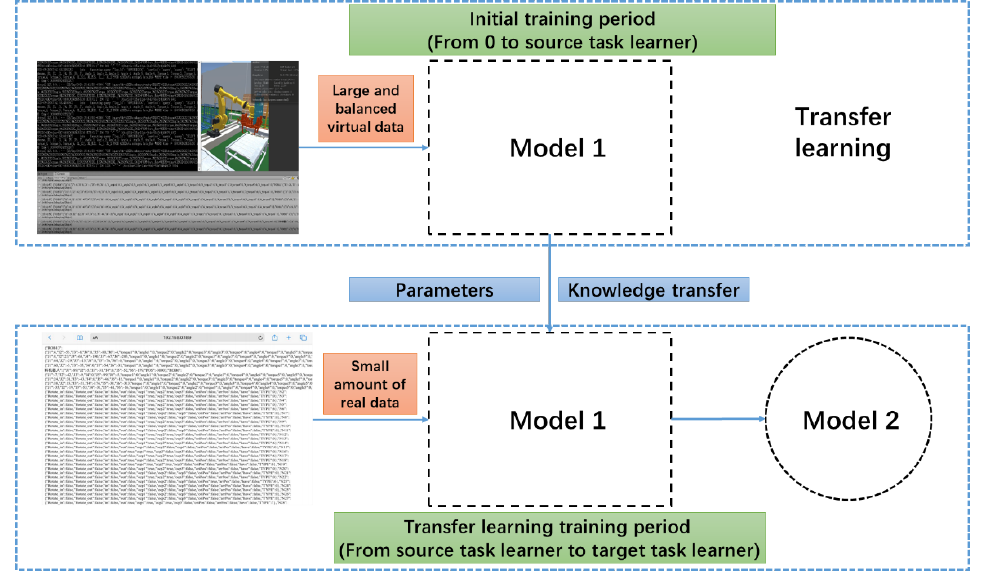
Figure 4. Digital Twin Assisted Transfer learning framework.